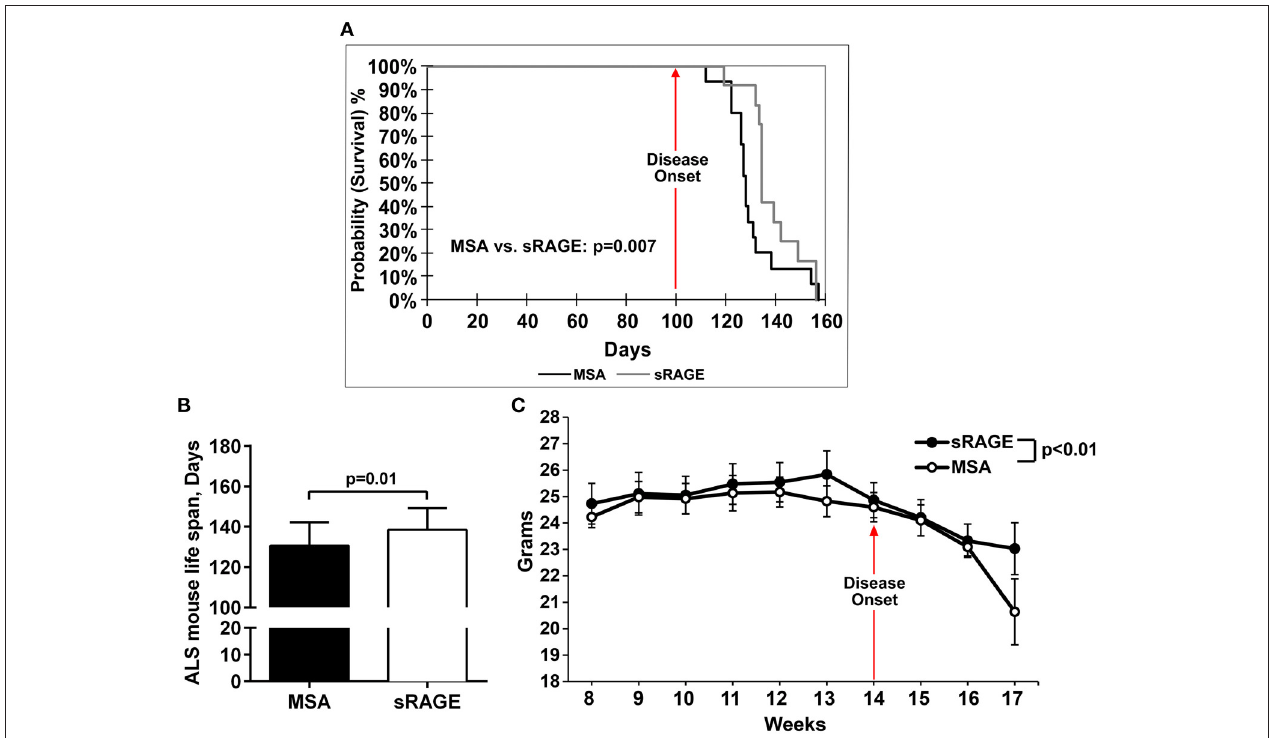
FIGURE 3 | sRAGE-treated SOD1 transgenic mice display greater longevity, higher survival probability and reduced weight loss vs. control mice. (A) Kaplan–Meier estimates, i.e., percentage of surviving mice plotted vs. survival time. Black line, MSA-treated mice, gray line, sRAGE-treated mice. (B) Mean life span of MSA- vs. sRAGE treated mice (days). The mean number of days lived by sRAGE treated mice was significantly higher compared to MSA-treated mice. (C) Decrease of body weight over time for both mice groups. Error bars represent SEM; disease onset is indicated by an arrow.